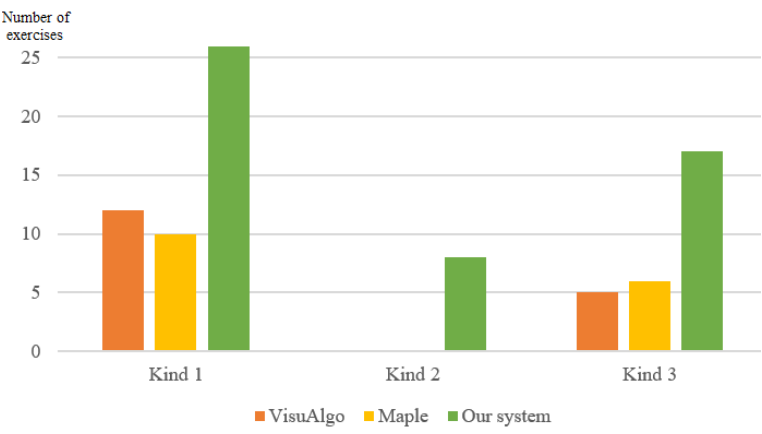
Figure 7. Results of testing of VisuAlgo, Maple, and our system.